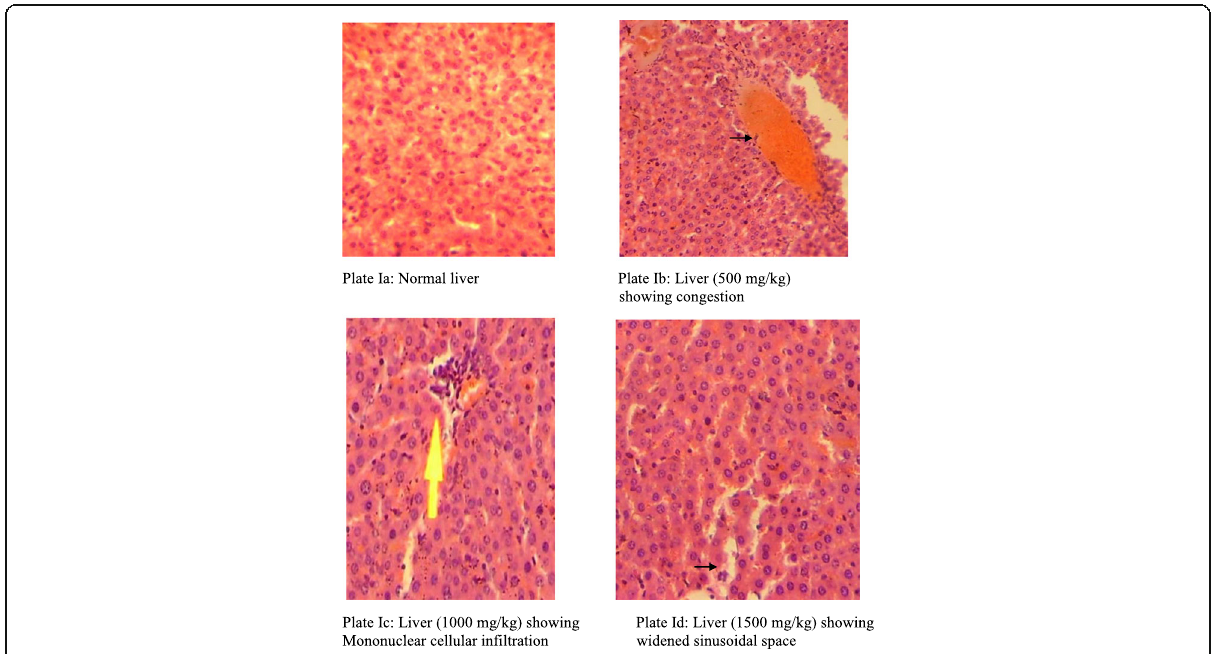
Fig. 1 Photomicrograph of the liver of rats administered aqueous extract of Spondias purpurea leaf (H and E × 200). a Normal liver. b Liver (500 mg/kg) showing congestion. c Liver (1000 mg/kg) showing Mononuclear cellular infiltration. d Liver (1500 mg/kg) showing widened sinusoidal space